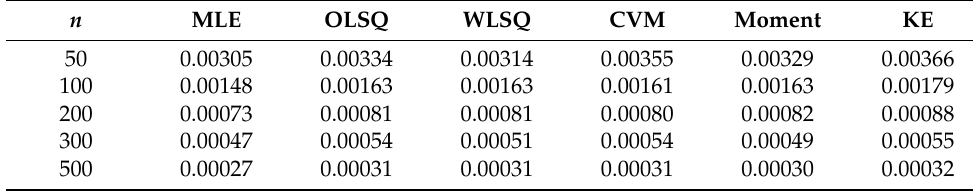
Table 1. Simulation results for δ =